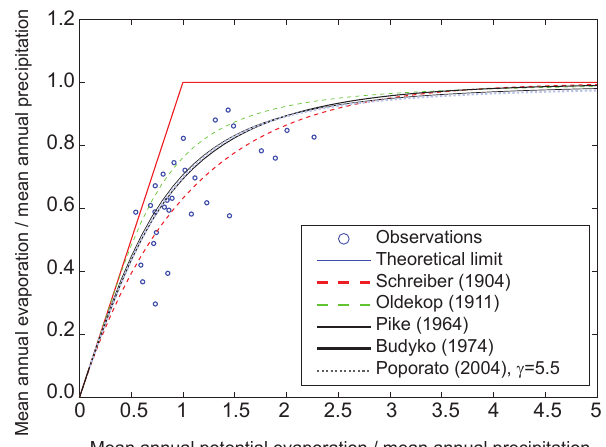
Fig. 3. From Gerrits et al. (2009), reproduced with the permis- sion of the authors: different representations of the Budyko curves and some observations. The 1:1 limit expresses the limitation by available energy, and the horizontal limit expresses the limitation by available